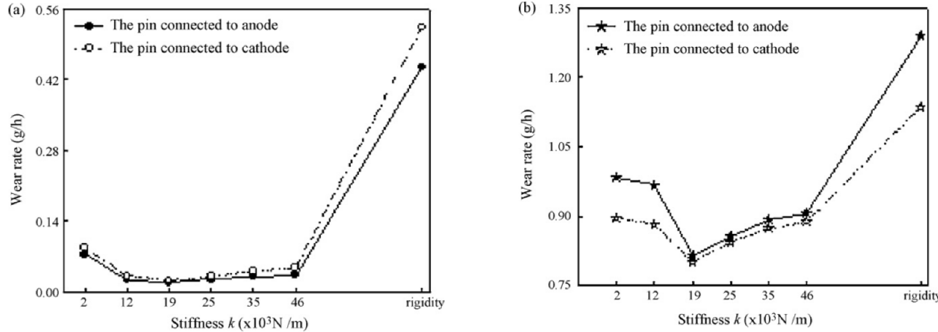
Figure 10. The wear rate as a function of spring rate: ( a ) I = 30 A, Fn = 80 N, v = 30 km/h, ( b ) I = 30 A, Fn = 80 N, v = 70 km/H [62].